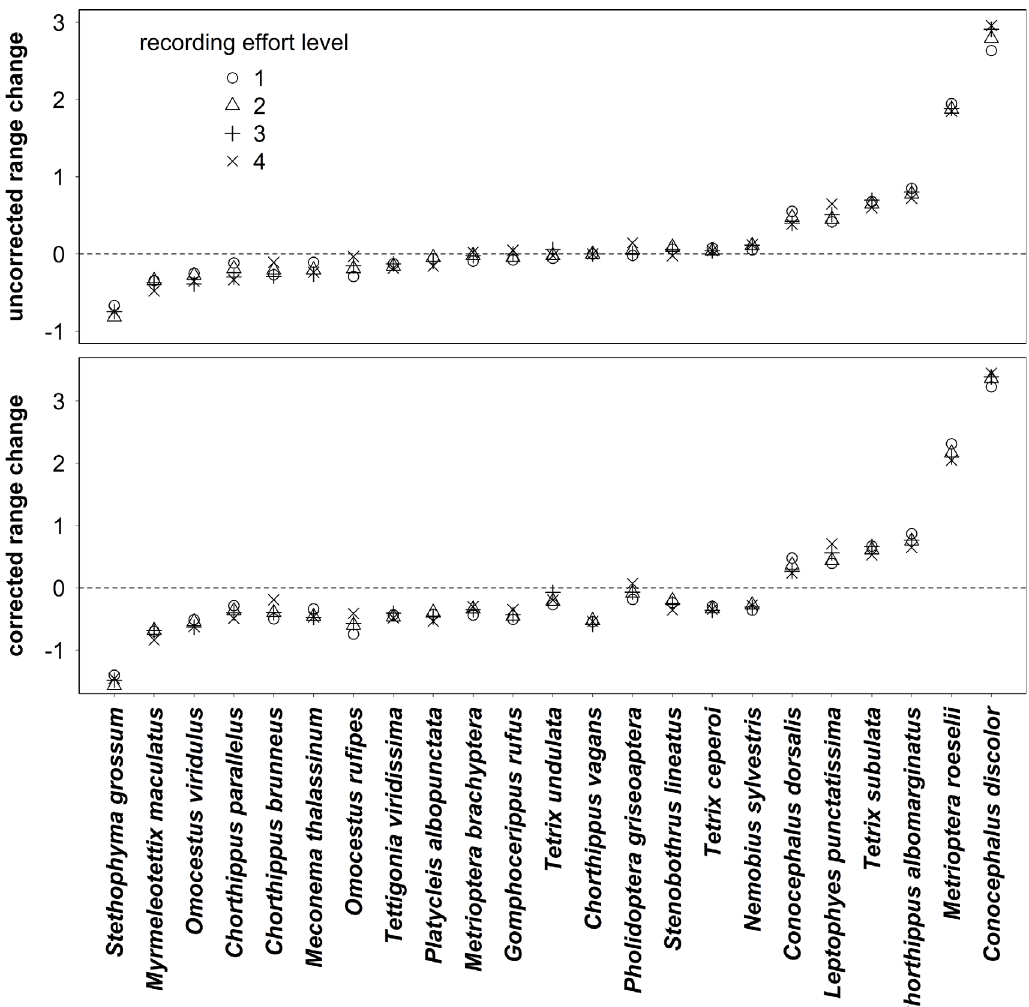
Fig 2. Range changes of grasshoppers and related species in Britain between 1980 – 9 and 2000 – 9. The figure shows “ uncorrected ” and “ corrected range change ” values for four levels of recording effort — i.e. based on four sets of “ surveyed squares ” with a minimum of 1 to 4 grasshopper or related species recorded in both time periods. Species are arranged in order of average uncorrected change. Note different y-axis